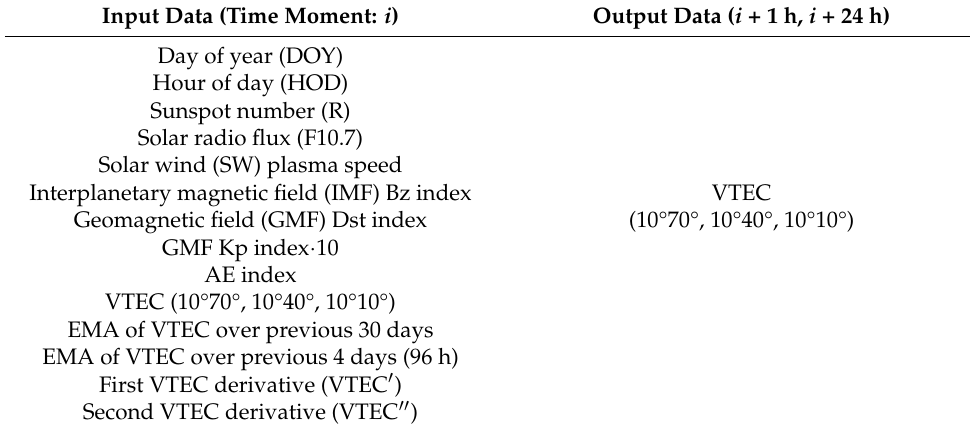
Table 1. Overview of input and output data for machine learning